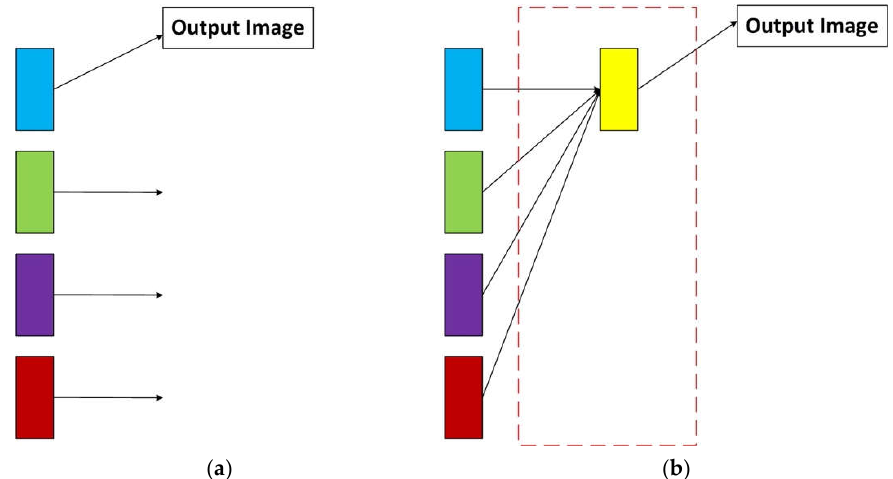
Figure 5. Network comparison. ( a ) The original network. ( b ) The newly added stage. The upward arrow is up-sampling, and the rectangles of different colors represent feature maps with different resolutions. In ( b ), the part framed by the red dotted line is the newly added stage.